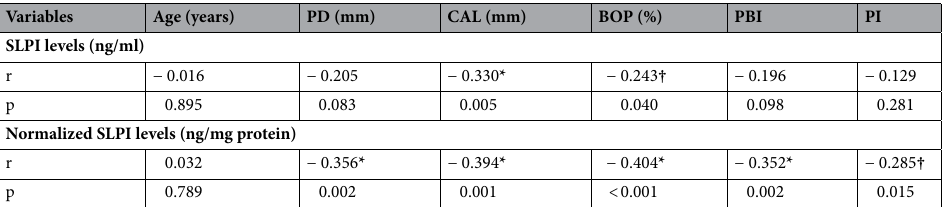
Table 3. Correlations of salivary SLPI levels with clinical periodontal parameters. According to Spearman’s rank correlation test, r: correlation coefficient and p: 2-tailed significance level. *Correlation is significant at 0.01 level. † Correlation is significant at 0.05 level. PD probing depth, CAL clinical attachment loss, BOP (%) the percentage of the bleeding on probing, PBI papillary bleeding index, PI plaque index, SLPI secretory leukocyte protease inhibitor, ng nanogram, mg milligram, ml milliliter, mm millimeter.